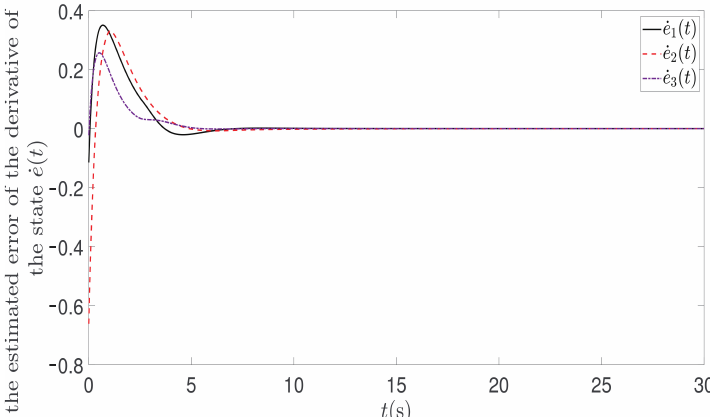
Figure 16. The error curves of the derivative of the states.